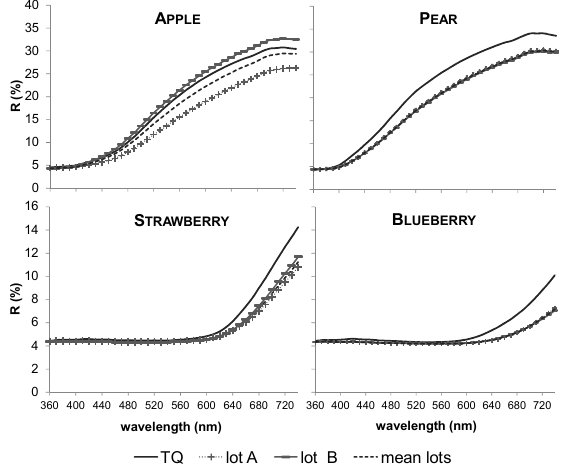
Figure 4. Reflectance spectra of RCW-fruit based drinks before (TQ) and after the pasteurization for each lot (lot A and lot B) and average reflectance spectra after pasteurization (mean